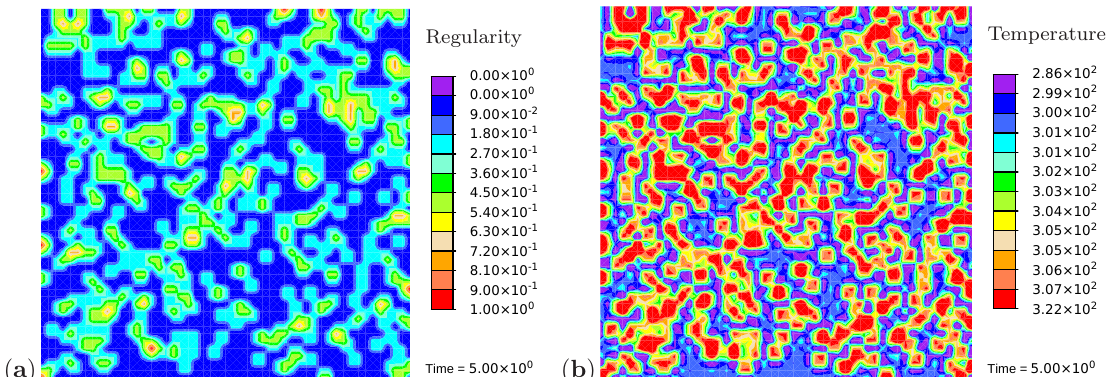
Figure 10. Cyclic tensile test with random initial microstructure. Snapshots of the microstructure evolution at the end of loading (¯ λ = 6.0) showing ( a ) regularity distribution and ( b ) temperature distribution (in Kelvin).